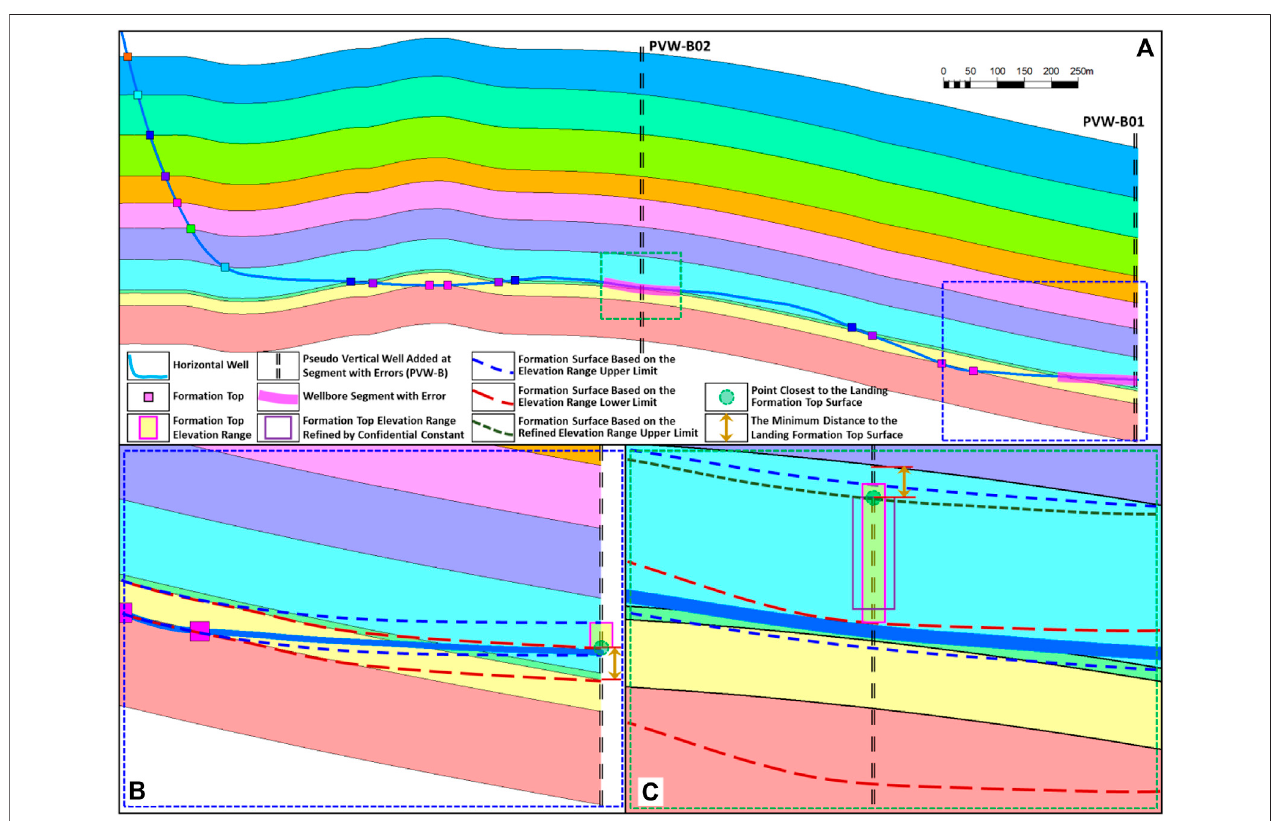
FIGURE4| Pseudoverticalwellsaddedforthewellsegmentswiththeincorrectlandingformation(PVW-B)andtheformationtopoftheintersectionpointslanding formation added for PVW-Bs. (A) Well JY-b and the well segments with error; (B) elevation range and the formation top using its lower limit; and (C) elevation range re fi ned by con fi dential constant and formation top using its upper limit. The two dash rectangles indicate the location of Figures 4B,C .